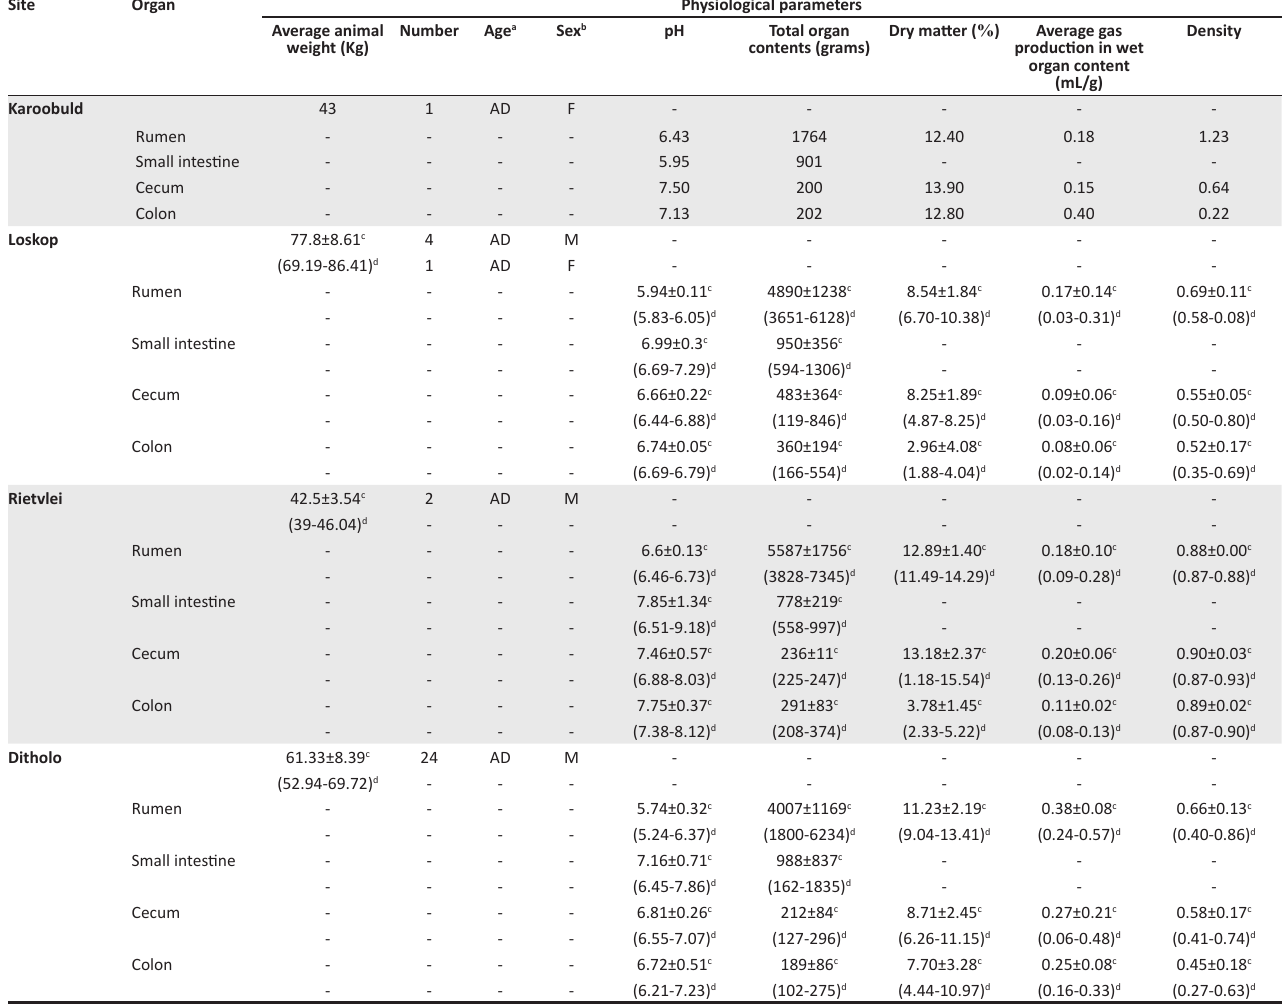
TABLE 4: Physiological parameters of the impala digestive tract and gas production by rumen, caecum and colon contents.